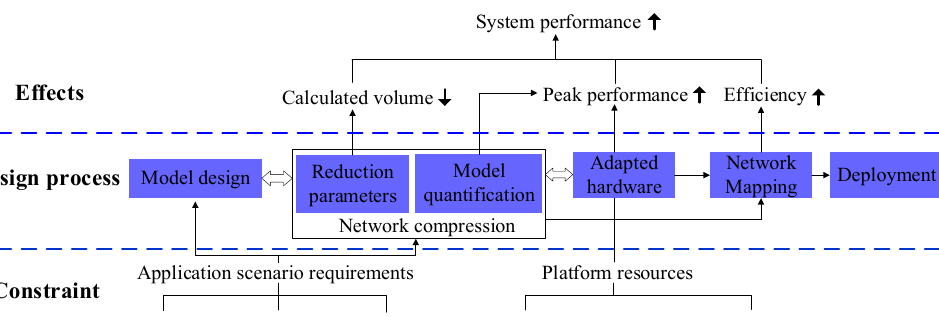
Figure 8. System design process.